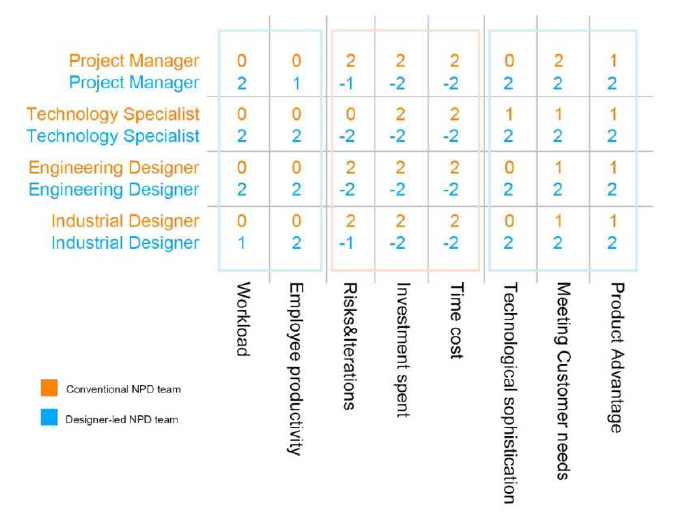
Figure 7: Result of Metrics Tool